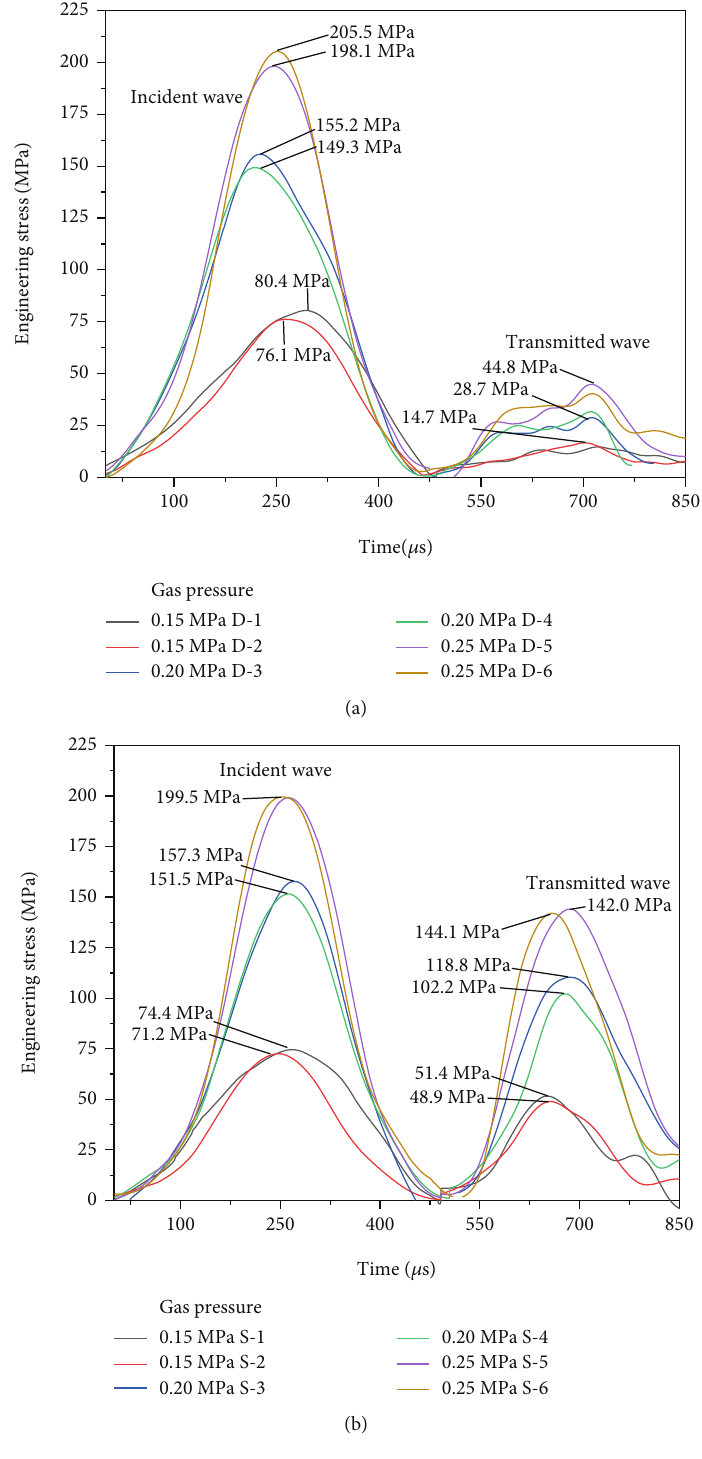
Figure 4: The incident waves induced by di ff erent gas pressure and corresponding transmitted waves through (a) dry sand and (b) saturated